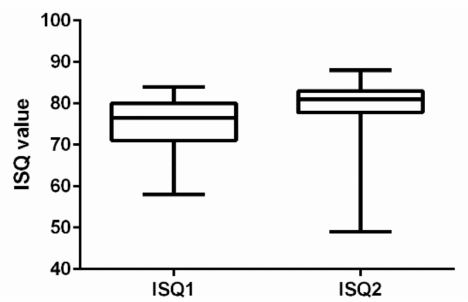
Figure 1. Paired t test for implant stability quotient (ISQ) values at implant placement (ISQ1) and after 3 months